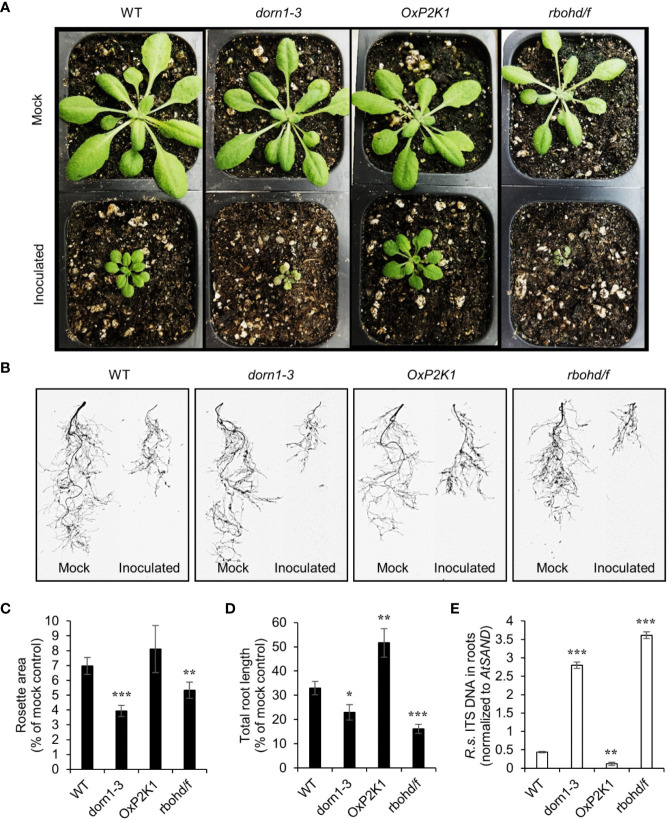
Effect of Rhizoctonia solani AG-8 infection on the aboveground rosette growth and the root growth of Arabidopsis. Eleven-day-old Arabidopsis seedlings were transferred to noninfested soil (mock) or soil infested with R. solani AG-8 C1 (150 CFU/g soil). Pictures of aboveground (A) and scan images of the root systems (B) were taken at 14 days of growth in the soil. The rosette areas of all four genotypes were measured as the smallest circle area enclosed by the convex hull of the rosette (C). The total root length was quantified using the WinRHIZO (D). Data are presented as the mean percentage ± S.E. (n = 8) relative to mock control. The level of infection in the roots quantified by real-time PCR based (E). Abundance is expressed as the ratios of the fungal-specific ITS region relative to the Arabidopsis reference gene AtSAND. The values are the means ± S.E. of three biological replicates. Asterisks indicate statistically significant differences compared with the WT control: Student’s t test; *P < 0.05; **0.001 < P < 0.01; ***P < 0.001.